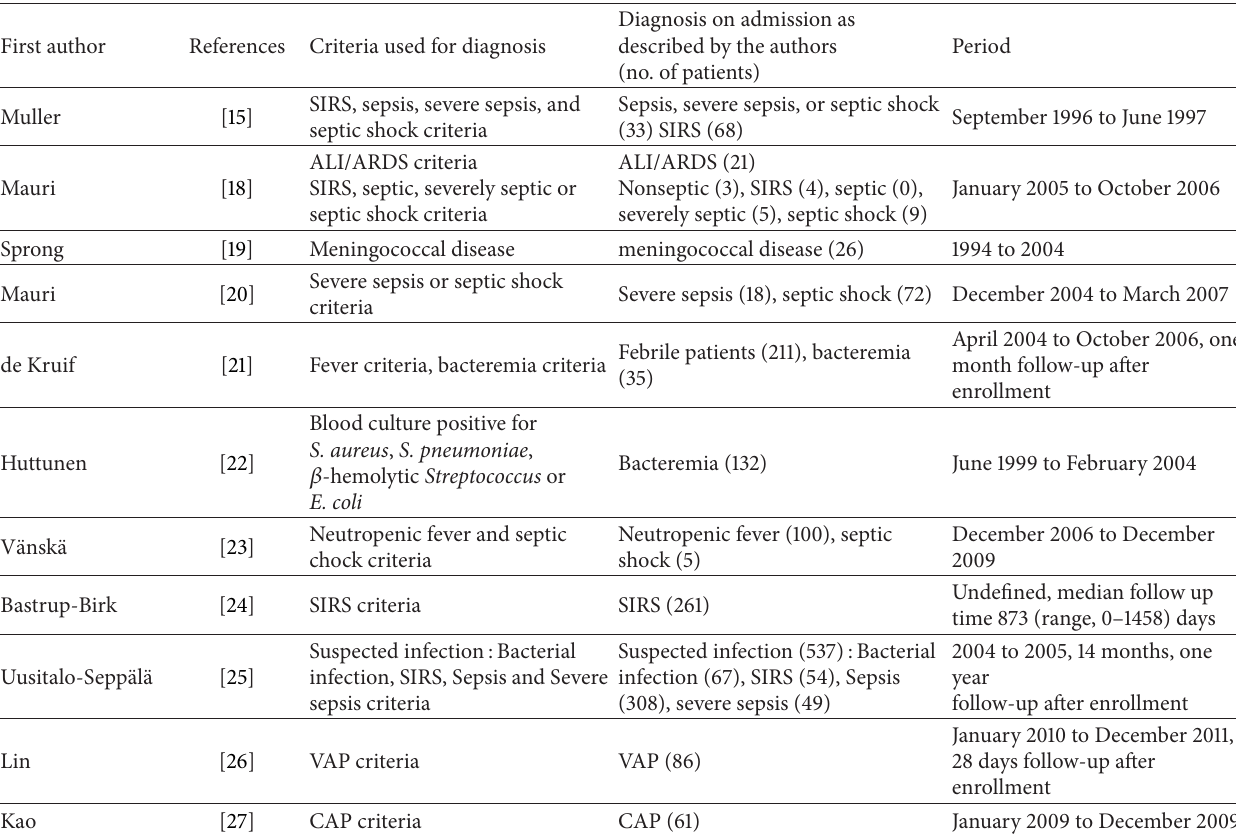
Table 2: Patients characteristics of the included